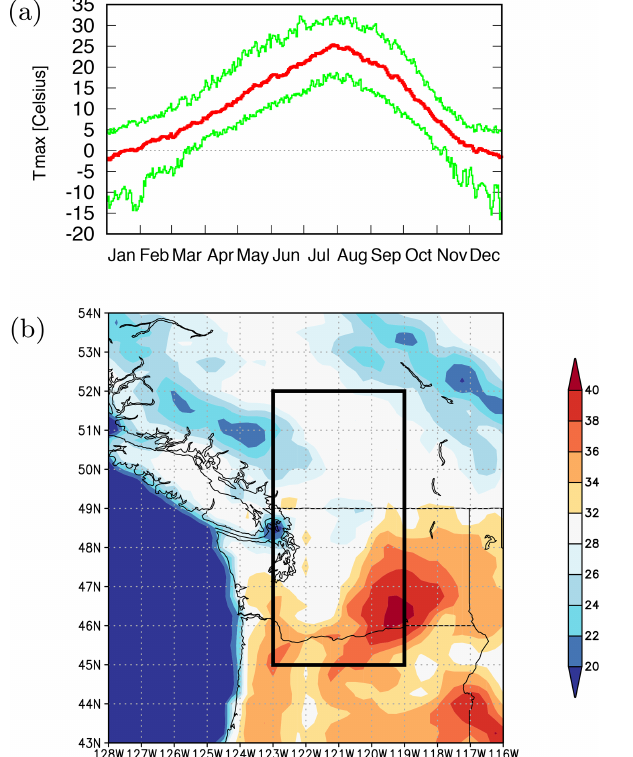
(a) Seasonal cycle of Tmax averaged over the land points of 45–52 ◦ N and 119–123 ◦ N, showing the 1950–2021 mean (red) and 2.5% and 97.5% percentiles of the distribution (green). (b) Spatial pattern of the 1950–2021 mean of the annual maximum of Tmax (multi-year mean TXx) at each grid point. Source: ERA5 (Hersbach et al.,